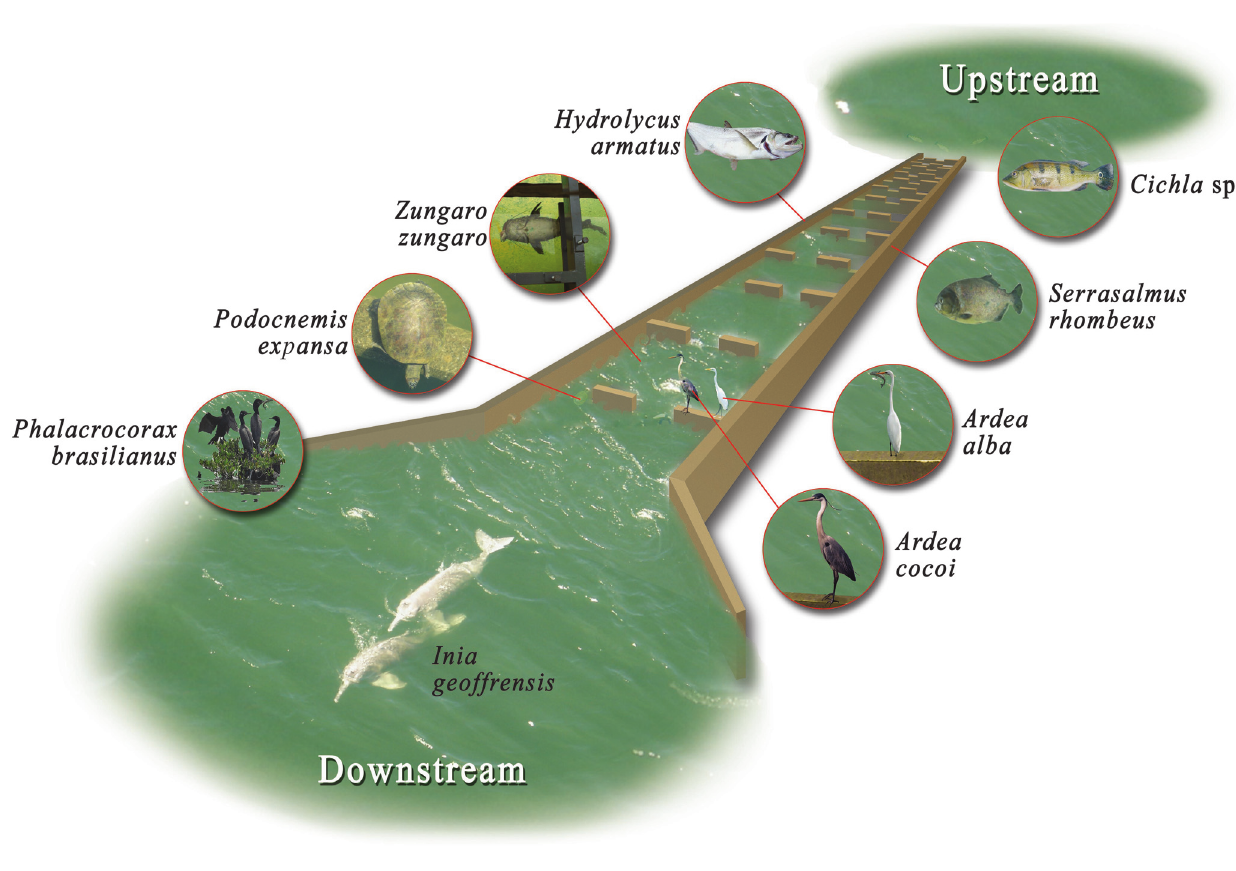
Fig. 4. Dominant predator species along the fish ladder at the Lajeado Dam, Tocantins